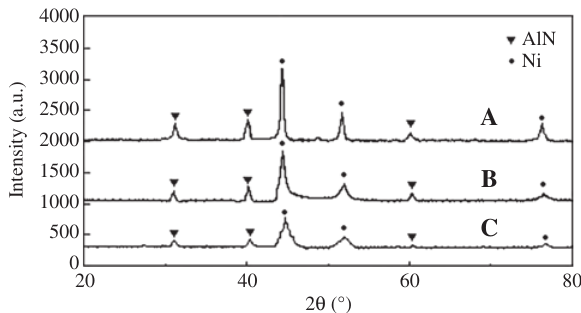
Figure 4 XRD patterns of Ni-AlN thin films deposited by (A) DC, (B) PC, and (D) UAPC